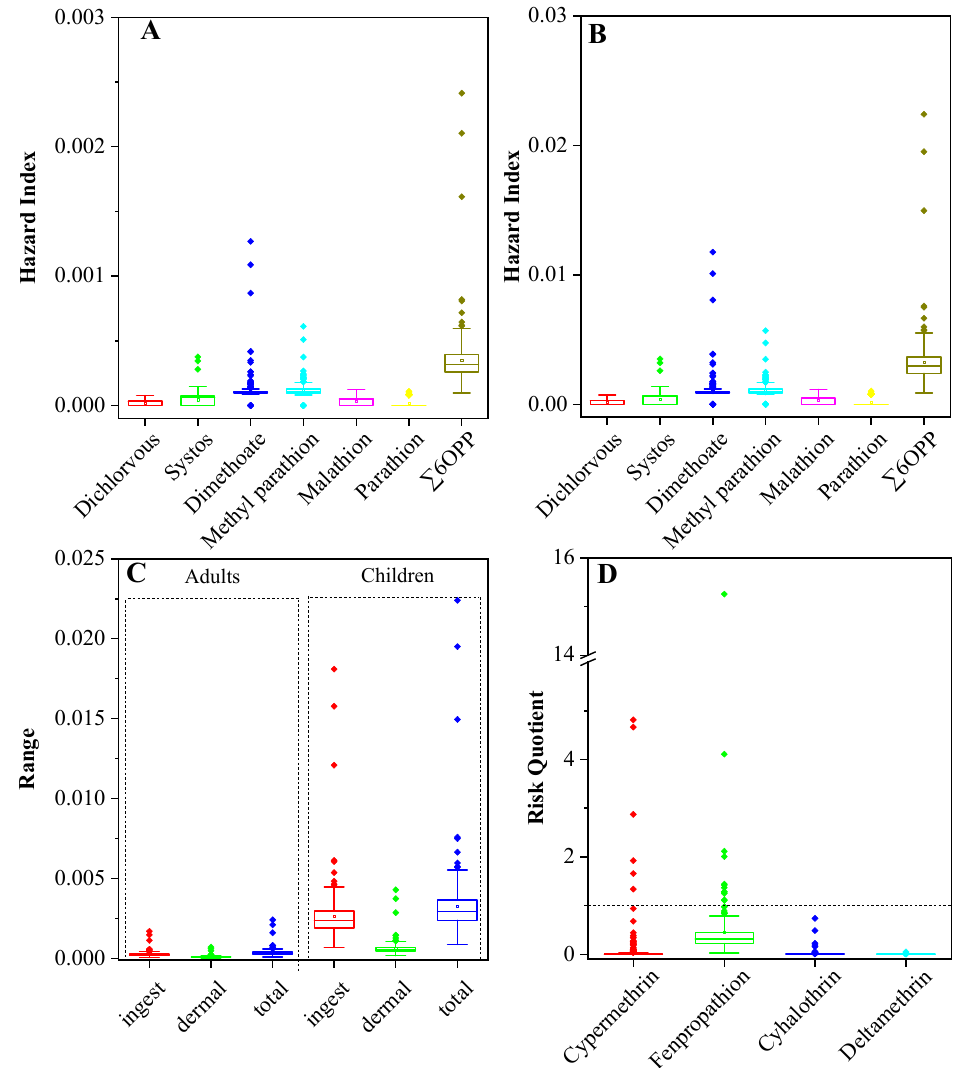
Figure 5. Non-cancer risks of OPPs to adults ( A ) and children ( B ), comparison of the contributions of different exposure pathways ( C ), and ecological risk of PYs in agricultural soils of the PRD region ( D ).